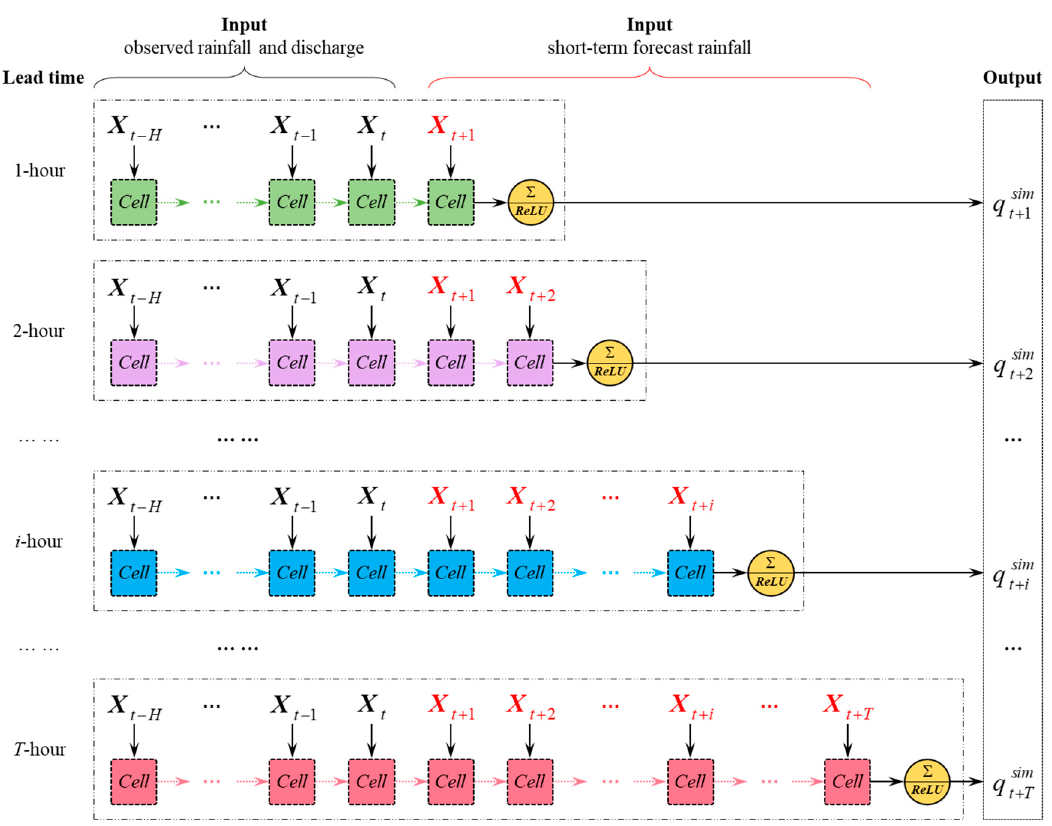
Figure 2. Structure of the LSTM flood forecasting model.